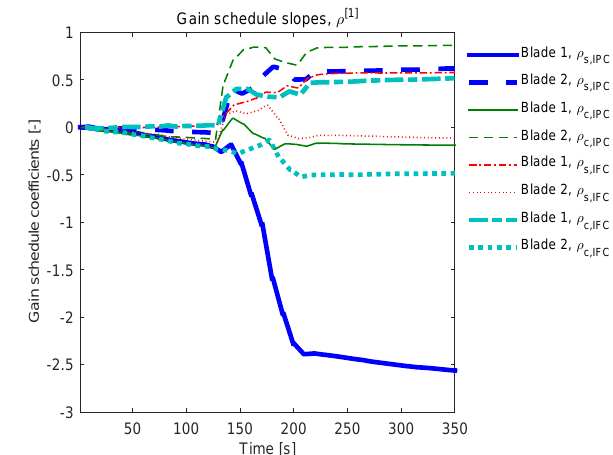
Figure 24. Gain schedule at varying wind speeds versus optimal gains at constant wind speed: pitch control.